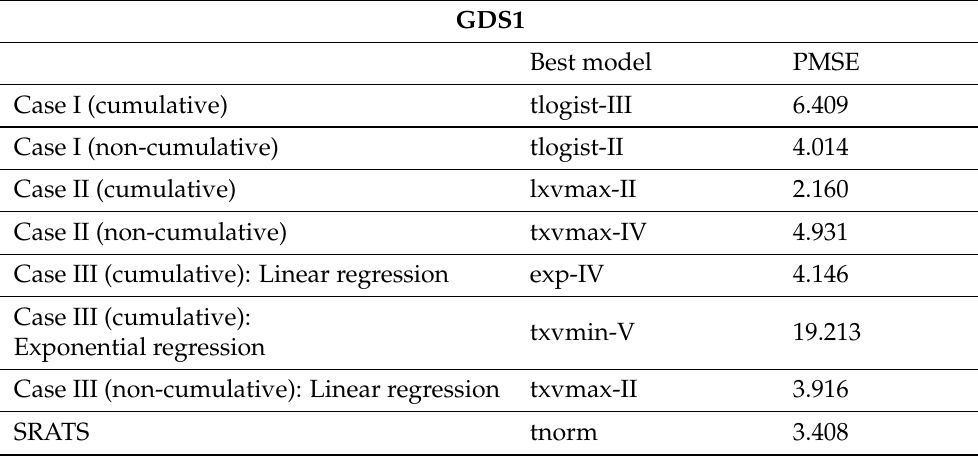
Table 5. Predictive performance based on PMSE at 50% observation